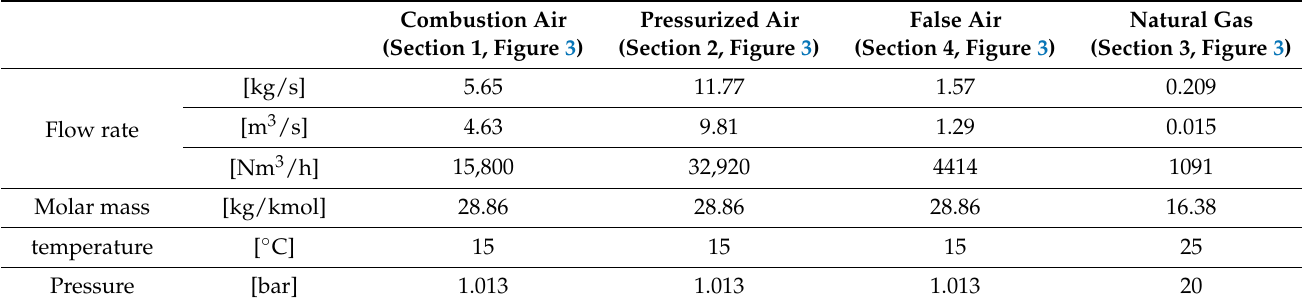
Table 2. Assumed conditions of gaseous inlet